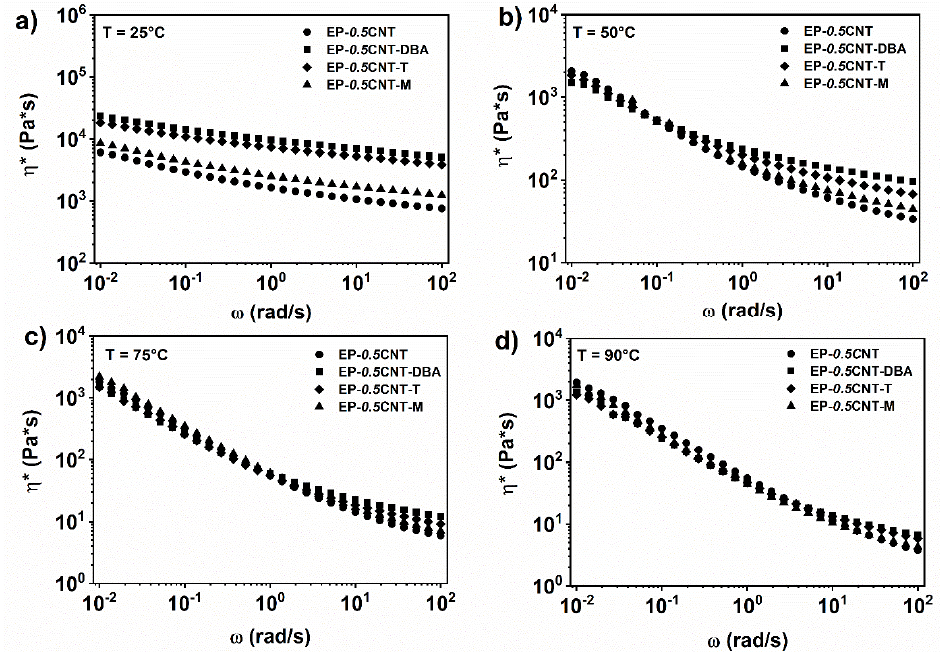
Figure 6. Complex viscosity ( η *) vs. frequency ( ω ) for EP ‐ 0.5 CNT, EP ‐ 0.5 CNT ‐ DBA, EP ‐ 0.5 CNT ‐ T and EP ‐ 0.5 CNT ‐ M at ( a ) T = 25 °C; ( b ) T = 50 °C; ( c ) T = 75 °C; ( d ) T = 90 °C.